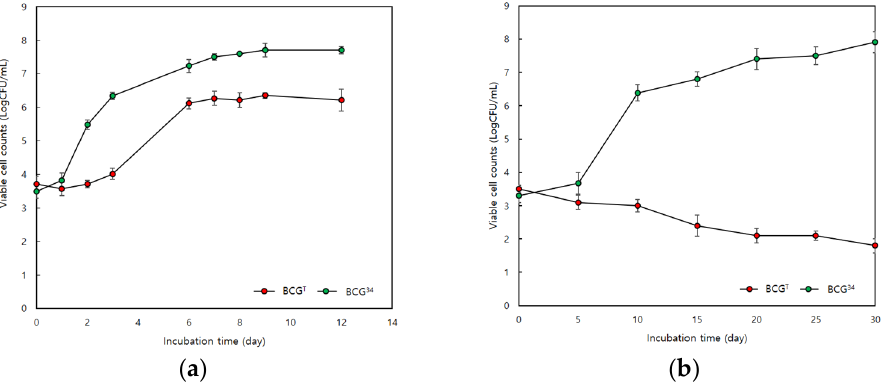
Figure 1. Growth curve of mesophilic B. cereus group strain (BCG T ) and psychrotolerant B. cereus group strain (BCG 34 ) at 10 °C ( a ) and 7 °C ( b ).